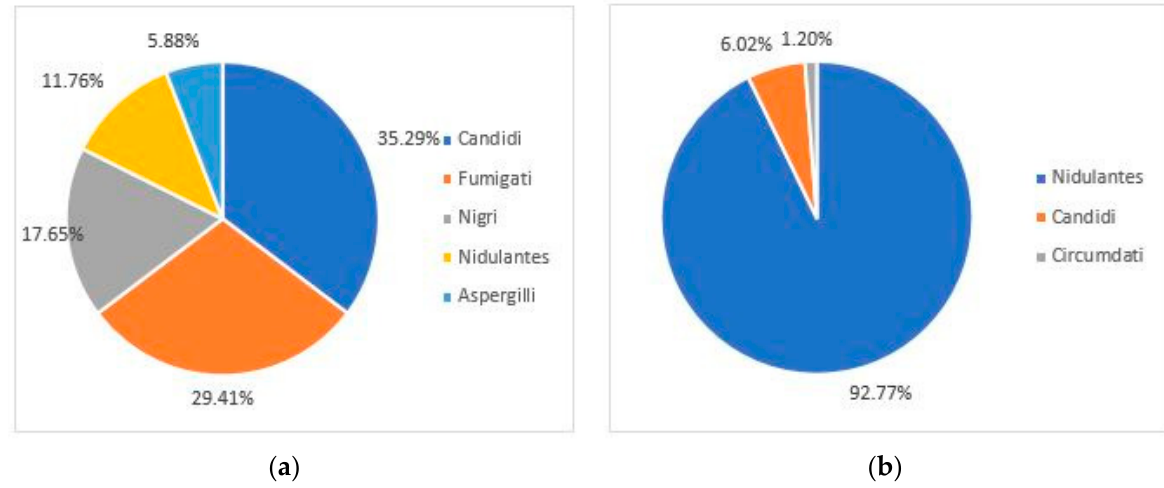
( a ) ( b ) Figure 6. Aspergillus sections distribution in surface swabs after inoculation onto ( a ) MEA and ( b ) DG18. 3.2. Azole Resistance Screening Positive fungal growth on at least one azole supplemented media was observed for 10 fungal species. Cladosporium sp. was the most abundant species in all three azoles (64.71% on ITR; 65.49% on VOR; 53.33% on POS). Penicillium sp. was also found in all three azoles, being the second most prevalent species in two of three azoles (14.79% on VOR; 22.22% on POS). Chrysosporium sp., Chrysonilia sitophila and Mucor sp. were also presented in all three azoles. Alternaria sp. and Aureobasidium sp. were only observed on ITR and VOR. Acremonium sp. and Rhizopus sp. were only detected on VOR and POS, respectively (Table 3). Table 3. Fungal distribution in azole-supplemented SAB media from surface swab samples. SAB ITR VOR POS